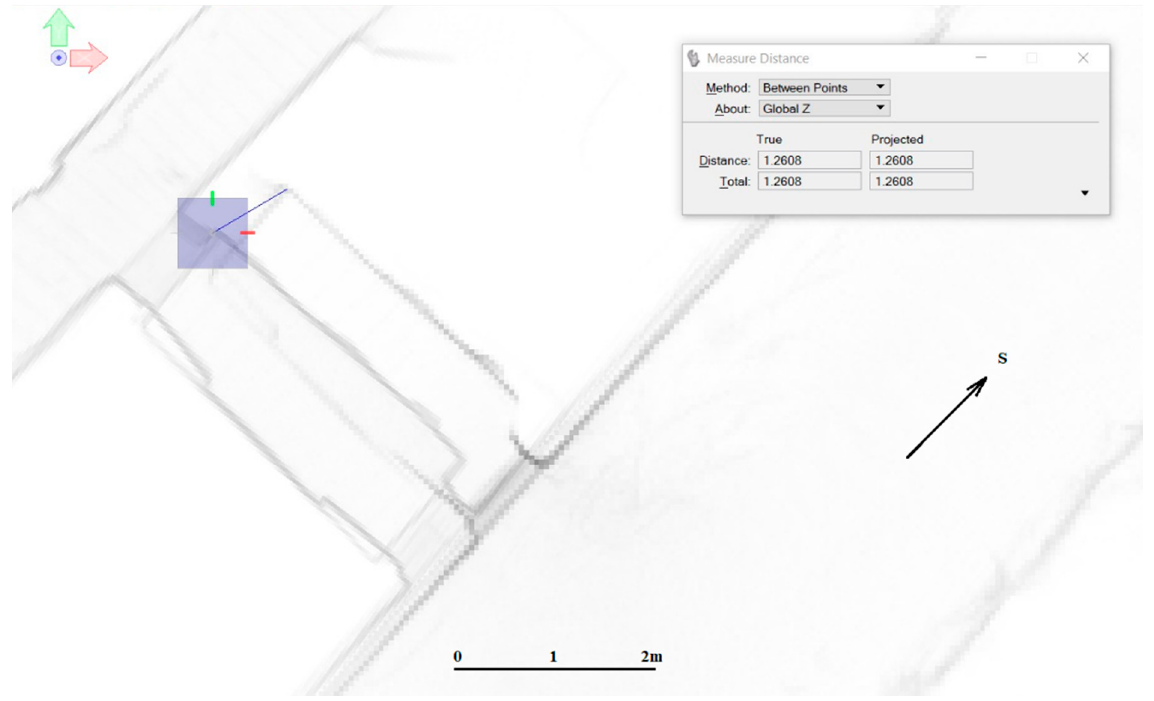
Figure 25. Deformation of both models.